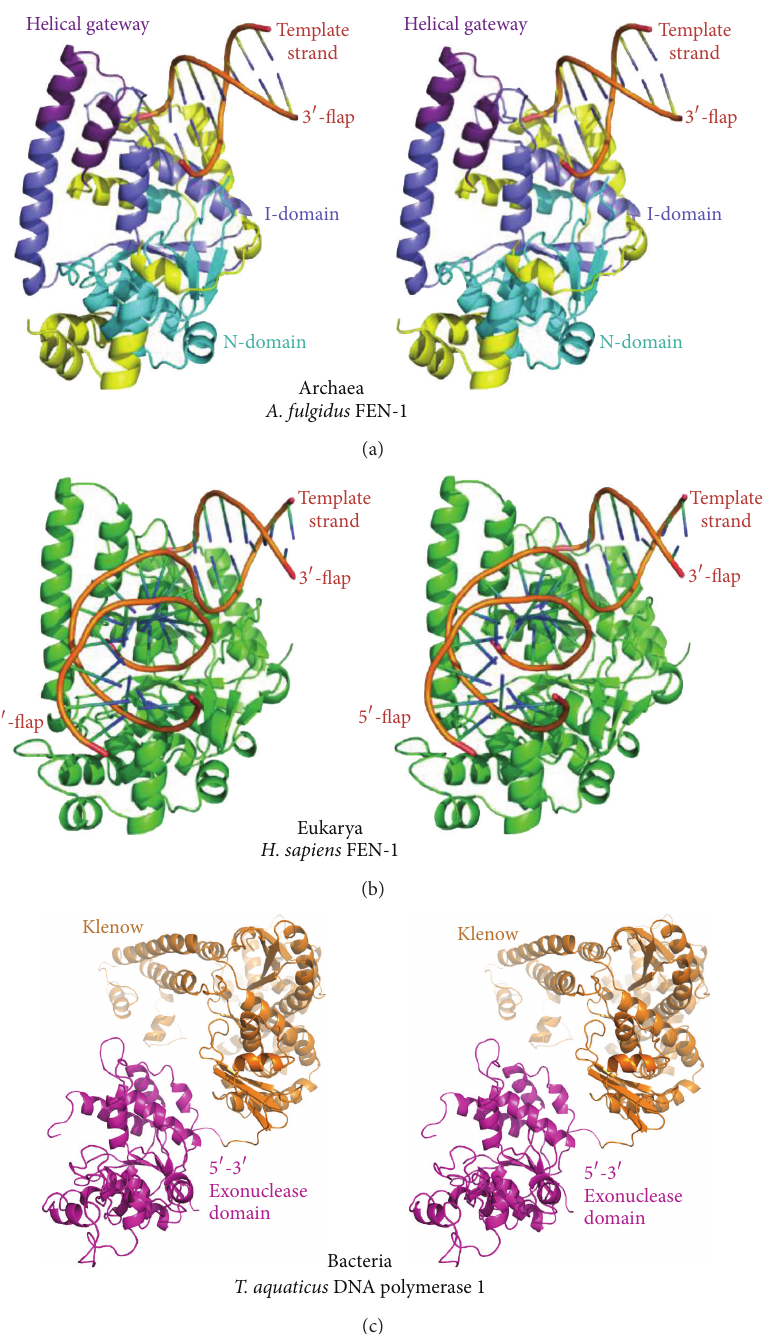
Figure 2: Comparison of FEN structures. Archaeal FEN-1 homologs share structural conservation with eukaryotic FEN1 proteins. (a) Stereoview of archaeal A. fulgidus FEN-1 in complex with DNA (PDB code 1RXW). The original conserved N and I regions are shown in light and dark blue, respectively. One strand of the short duplex DNA segment represents a 3 󸀠 flap substrate, while the other represents the template strand. The helical gateway segment used to guide DNA is shown in purple. (b) The stereoview of the human FEN1 structure reveals the conservation of tertiary structural fold between archaeal FEN-1 proteins and eukaryotic FEN1 proteins. The more complex double-flap substrate revealed insights into the DNA binding mode and active site chemistry (PDB code 3Q8M). (c) The structurally related “FEN-1” of bacteria is the 5 󸀠 -3 󸀠 exonuclease of DNA polymerase 1 shown in the stereogram in magenta (PDB code 1TAQ). This domain is tethered to the Klenow fragment that carries the DNA polymerase